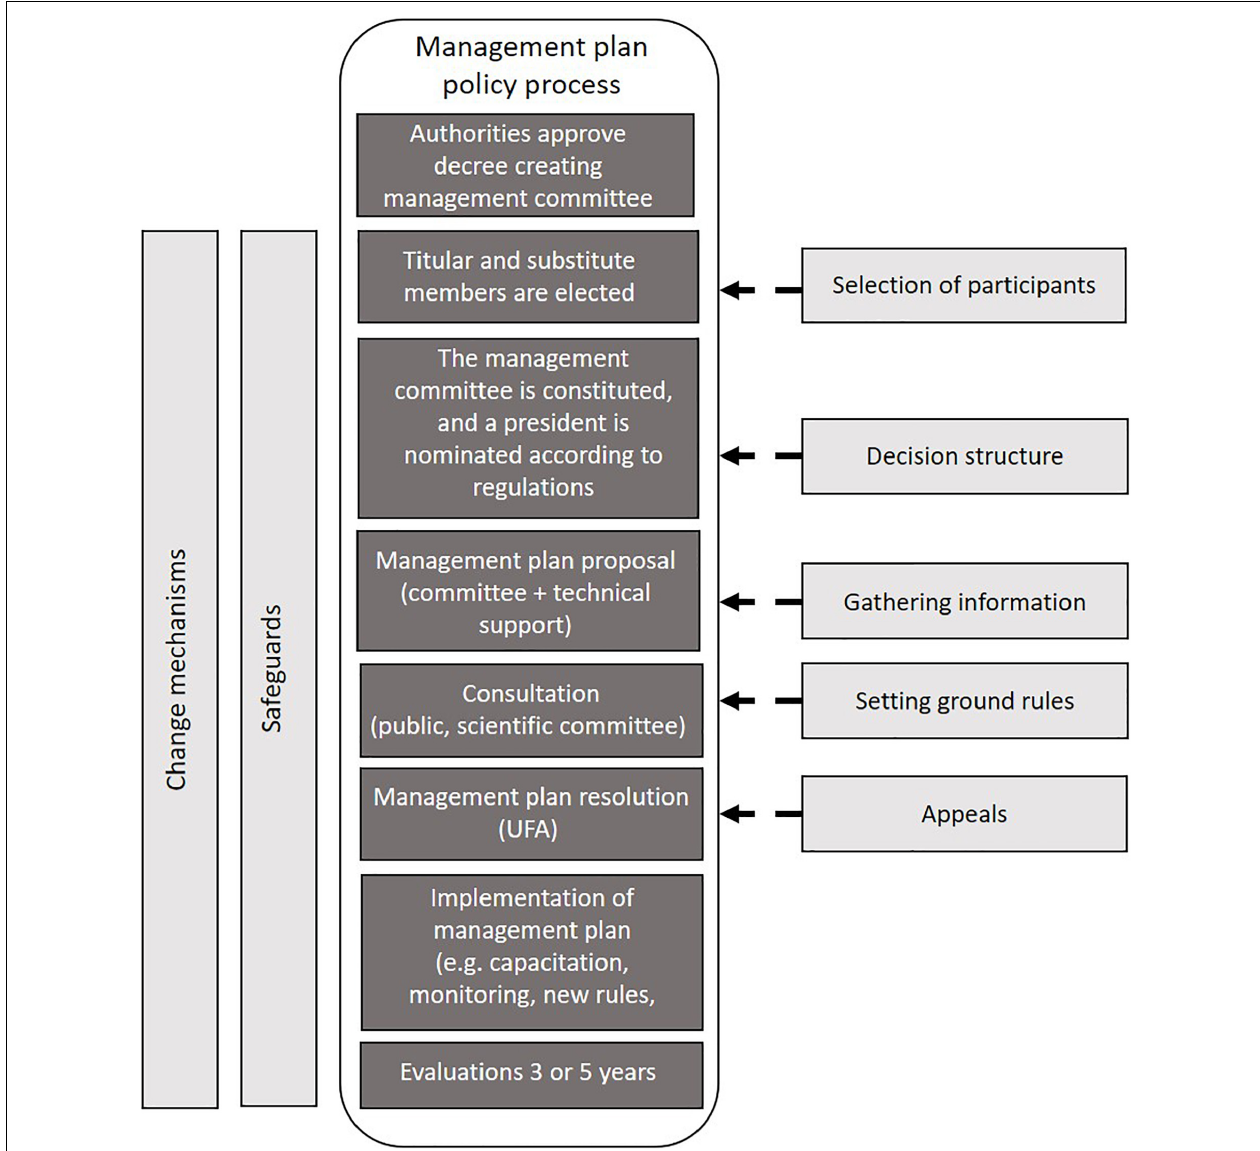
FIGURE 1 | Stages for the implementation of the management plan by the management committee (dark gray boxes) and the seven components of Leventhal’s procedural justice (Leventhal, 1980) (clear gray boxes). UFA, Undersecretary of Fisheries and Aquaculture.